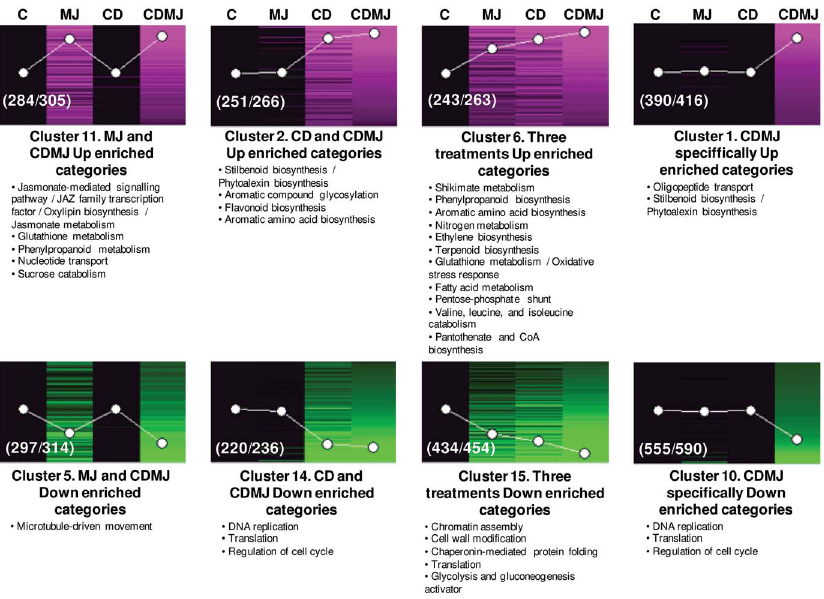
Figure 3. Functional categories enriched in clusters of transcripts sharing the same expression response to the treatments. Significant enrichment was only found in clusters 1, 2, 5, 6, 10, 11, 12, 14, and 15 from Figure S2. All non-redundant over-represented categories are listed below the corresponding cluster in order of significance except for related categories that are grouped in the same line. Significant enrichment according to Bonferroni-Hochberg adjusted P -value , 0.05 in a Fisher’s exact test. Magenta and green intensity, level of up-regulated or down- regulated expression respectively, 24 h after treatment and normalized to the control; Black, transcripts not significantly regulated by the treatment. C, control; MJ, methyl jasmonate; CD, cyclodextrins; CDMJ; cyclodextrins and methyl jasmonate. The numbers in brackets indicate non-redundant transcripts/total probesets included in the cluster.